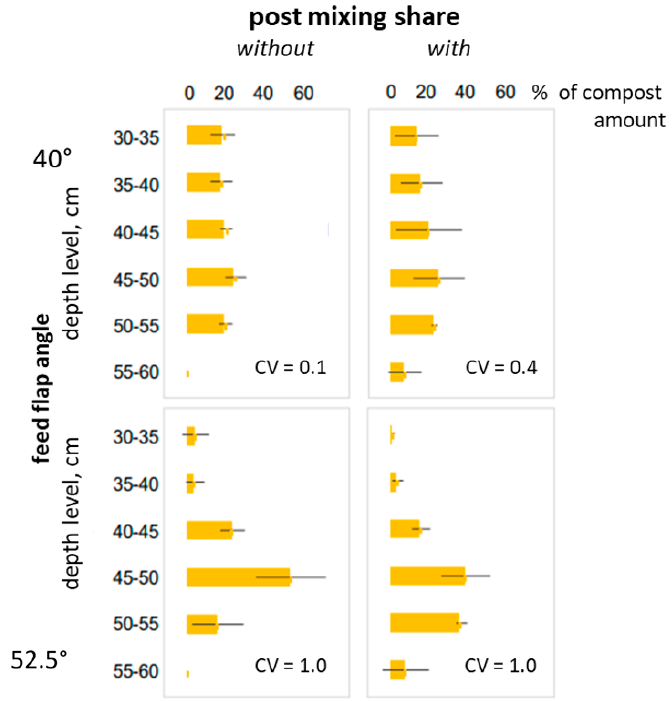
Figure 9. Mixing quality of compost and subsoil and impact of an additional mixing coulter for different feed flap settings, rated by the coefficient of variation and distribution (%) in the different layers.